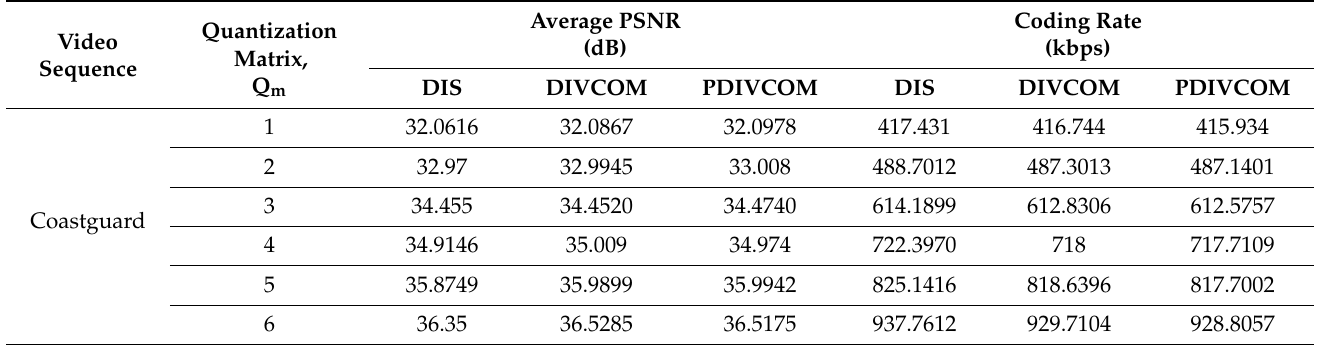
Table 2. Visual quality and rate performance evaluation of different codecs for “Coastguard” video sequence at frame rate of 15